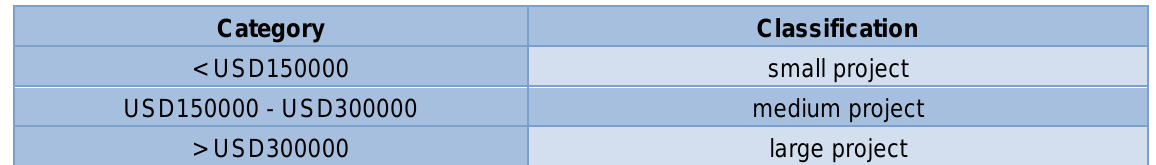
Table 3 Classification of road construction projects in the West Bank (PECDAR,